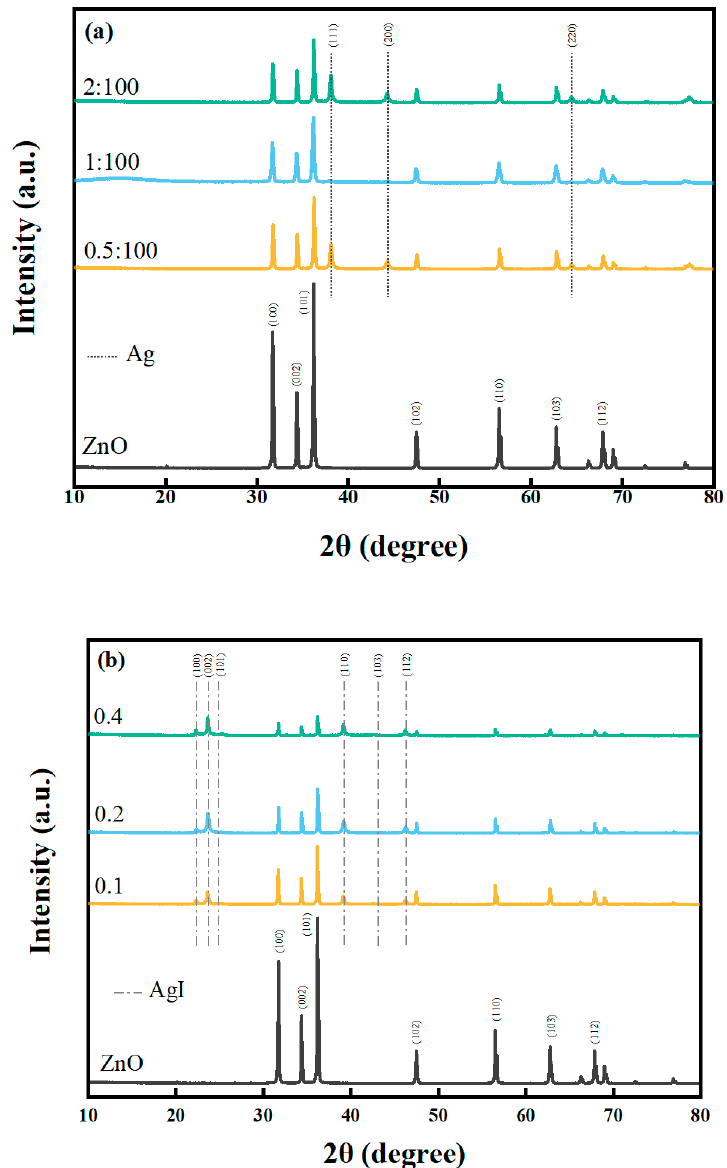
Figure1. XRDpatternsofdi ff erentAg / ZnOandAgI / ZnOphotocatalystsintherange10–80 ◦ . ( a )Ag / ZnO, Figure 1. XRD patterns of different Ag/ZnO and AgI/ZnO photocatalysts in the range 10–80°. ( a ) ( b ) AgI / Ag/ZnO, ( b ) AgI/ZnO.